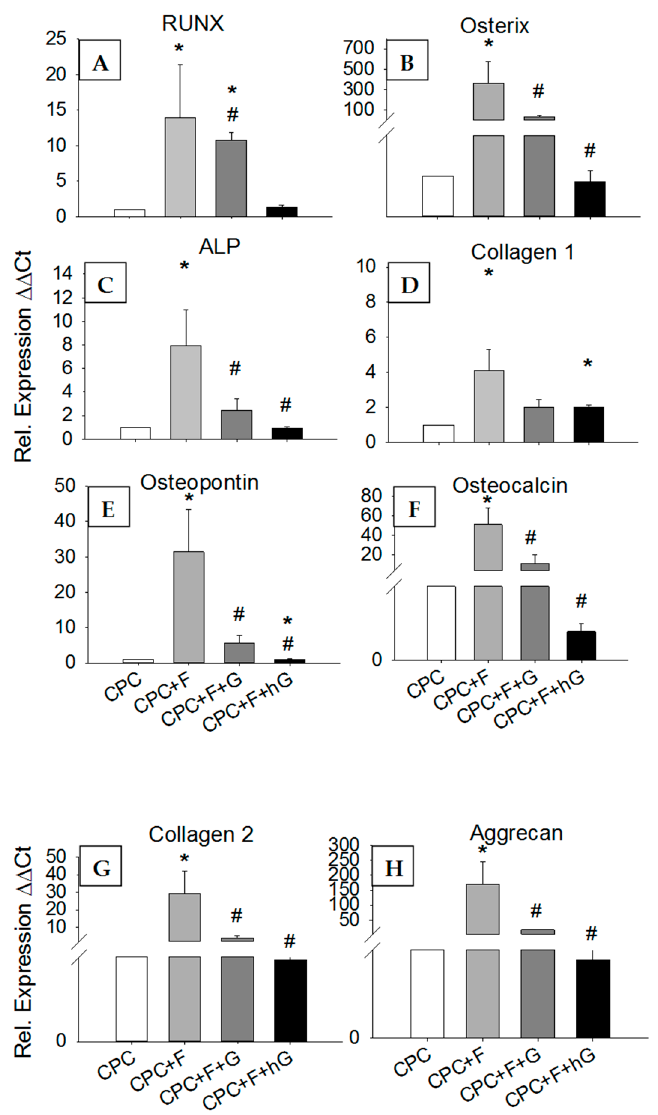
Figure 8. Effects of GDF5 extracts on the gene expression in hASCs. hASCs were seeded in 12-well plates and exposed for 3 days to the diluted extracts of CPC discs without fibers (CPC) and with 10% ( w / w ) fiber content (CPC+F), the latter either without GDF5 or doped with low dose (10 µg/mL; CPC+F+G) or high dose GDF5 (200 µg/mL; CPC+F+hG). Thereafter, the mRNA expression of Runx2 (RUNX; A ), osterix ( B ), alkaline phosphatase (ALP; C ), type I collagen ( D ), osteopontin ( E ), osteocalcin ( F ), type II collagen ( G ), and aggrecan ( H ) was measured using RT-PCR and the data were expressed as relative expression (as determined using the ΔΔ Ct method) compared to the CPC without fibers and growth factor; data are expressed as means ± SEM ( n = 8); * p ≤ 0.05 Mann–Whitney U test vs. CPC; # p ≤ 0.05 Mann–Whitney U test vs. CPC+F.